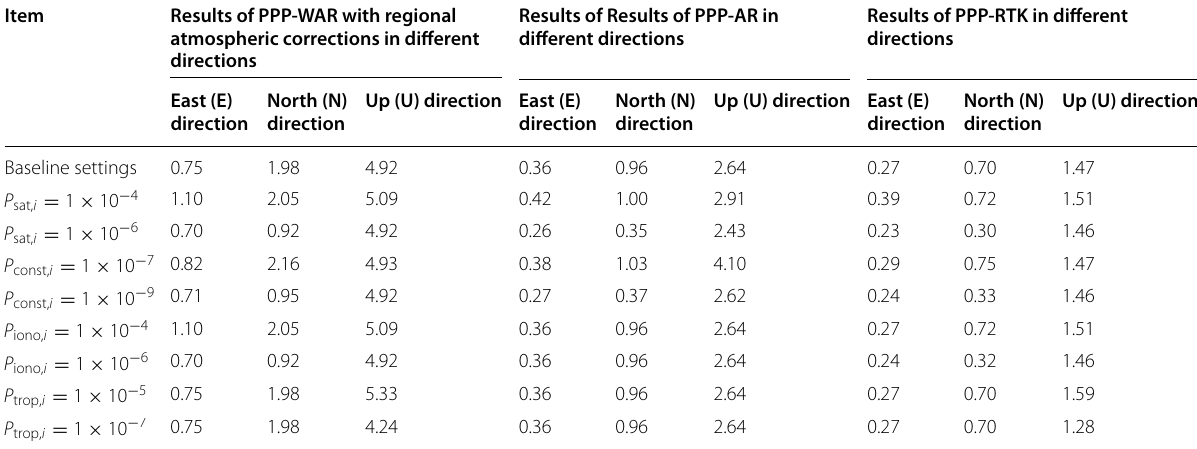
Results of Results of PPP-AR in different directions